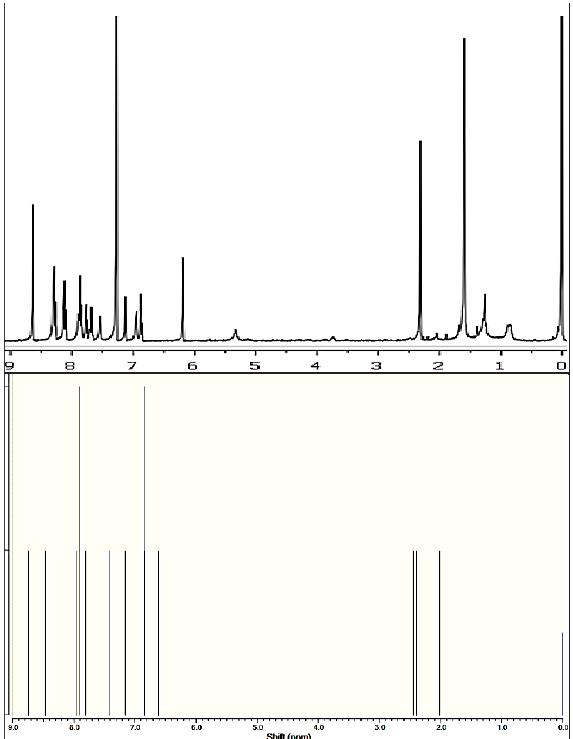
Figure 3: Experimental (above) and theoretical (below) 1 H-NMR spectra of the PINQ. 13 C-NMR spectrum showed a chemical shift at 146.85 ppm assigned to the imine group revealing the formation of the PINQ molecule by the condensation reaction of 1,4-